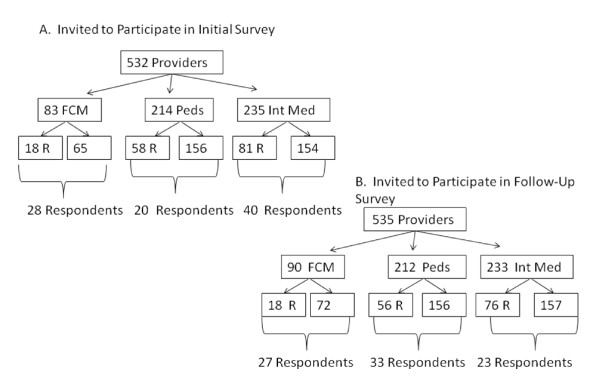
Providers Invited to Participate in Herbal and Natural Product Assessment. (A) Initial Baseline Survey to assess H/NP attitudes, experiences and knowledge in 2008. (B) Second Follow-up Survey to assess the extent the electronic tool changed attitudes, experiences, and knowledge, 2009. FCM, Department of Family and Community Medicine; Peds, Department of Pediatrics; Int Med, Department of Internal Medicine; R, residents.